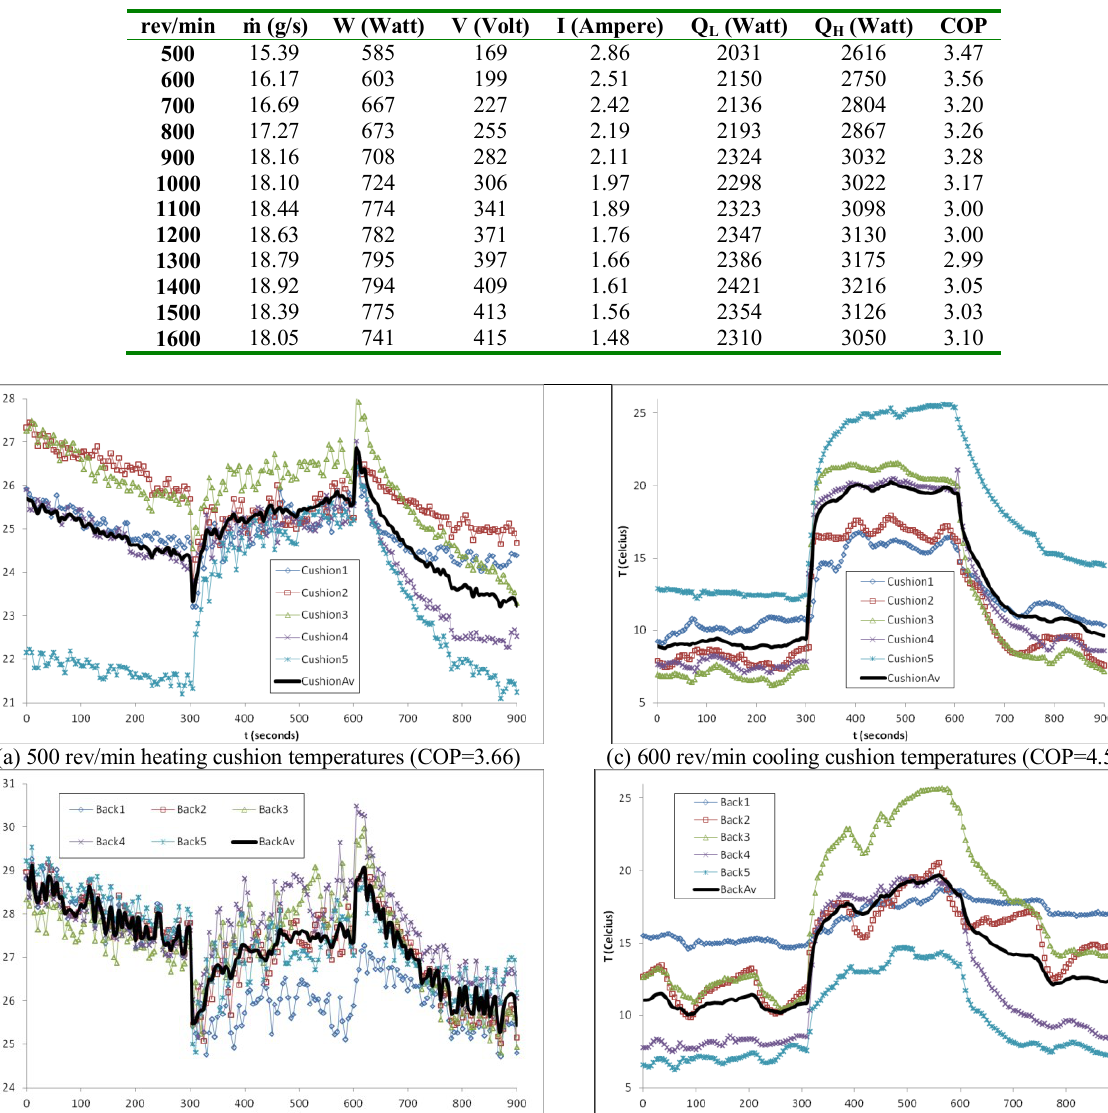
Table 3. Air conditioner indicator values for cooling process